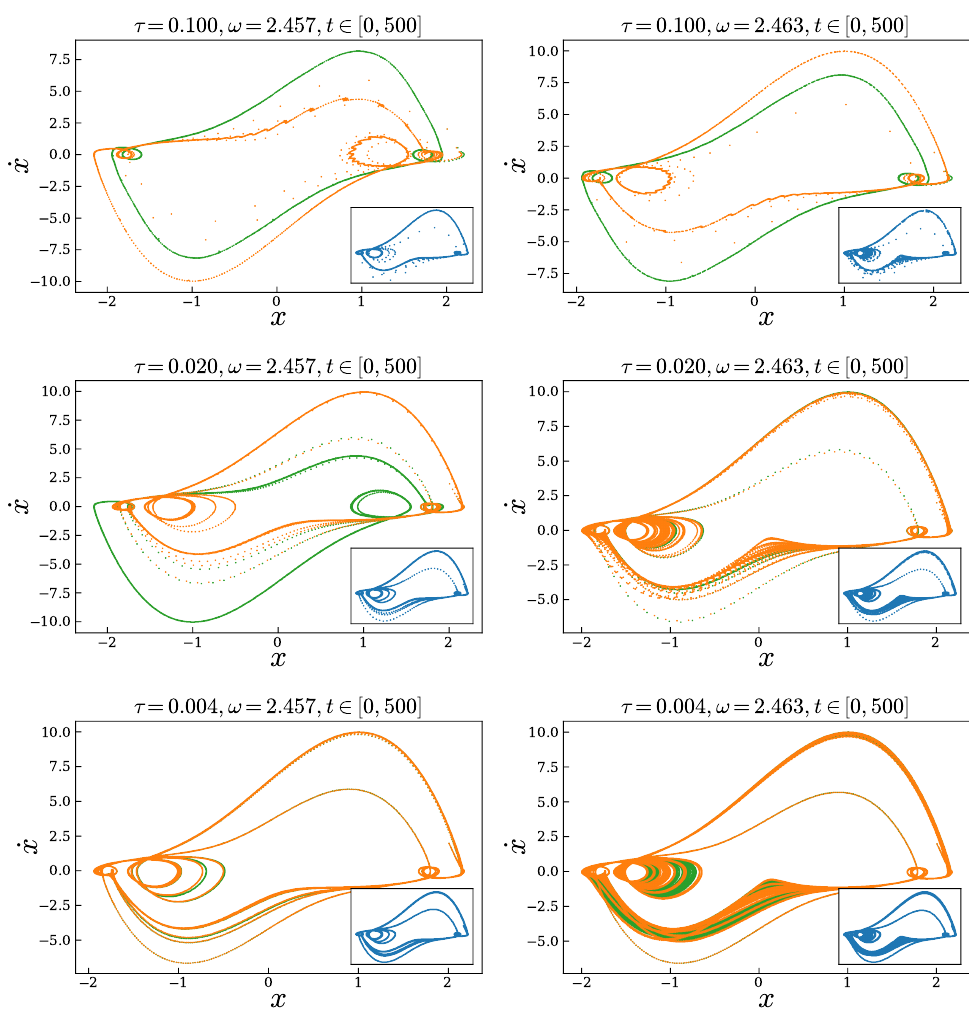
Figure 10. Orbit of the forced van der Pol oscillator with ( x 0 , ˙ x 0 ) = ( 2,2 ) . The green dots corre- spond to the second order integrator and the orange dots to a sixth order approximate integrator (CBABC) with the coefficients taken from family A in Table 1. Left: Regular attractor. Right: Strange attractor. From top to bottom the time step is decreasing. The inset plots contain the corresponding trajectory computed with LSODA. It is plotted separately because, besides the first row, it is virtually indistinguishable from the one obtained with the sixth order